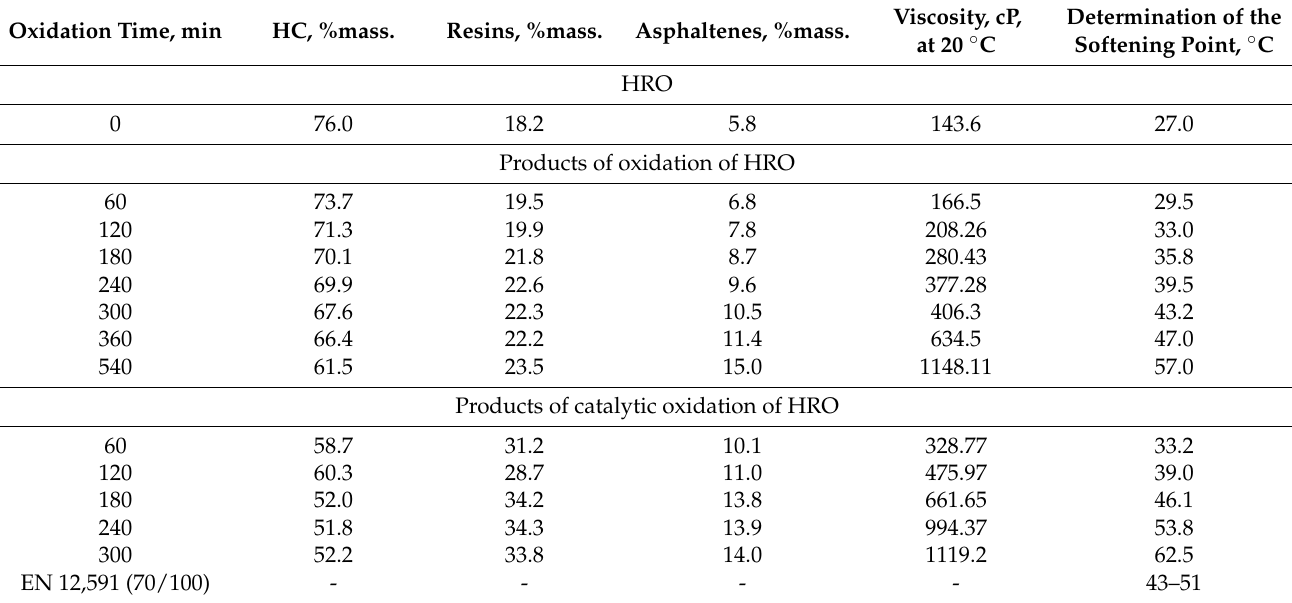
Table 1. Component composition and physicochemical properties of the initial heavy residual oil (HRO) and its oxidation products.